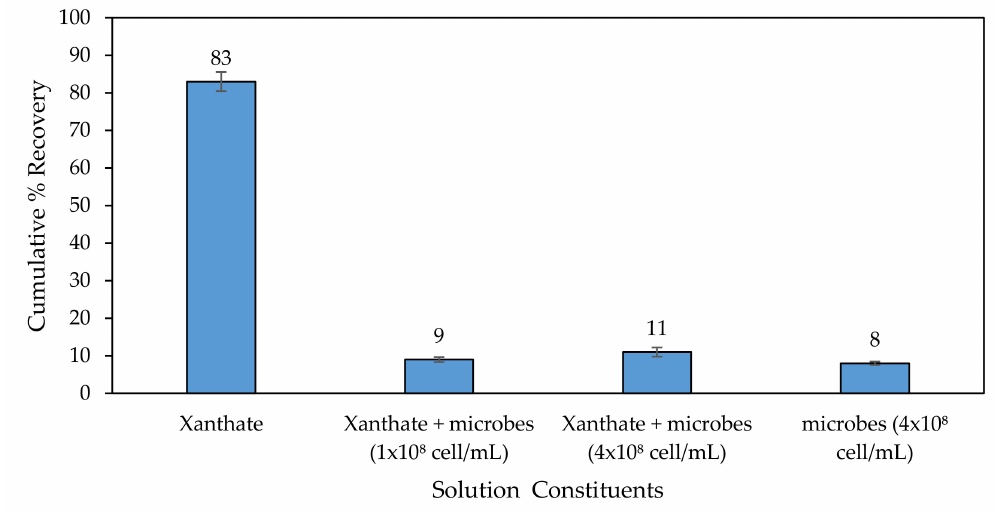
Figure 5. Chalcopyrite cumulative recoveries in the presence and absence of a 50% pseudo-monolayer